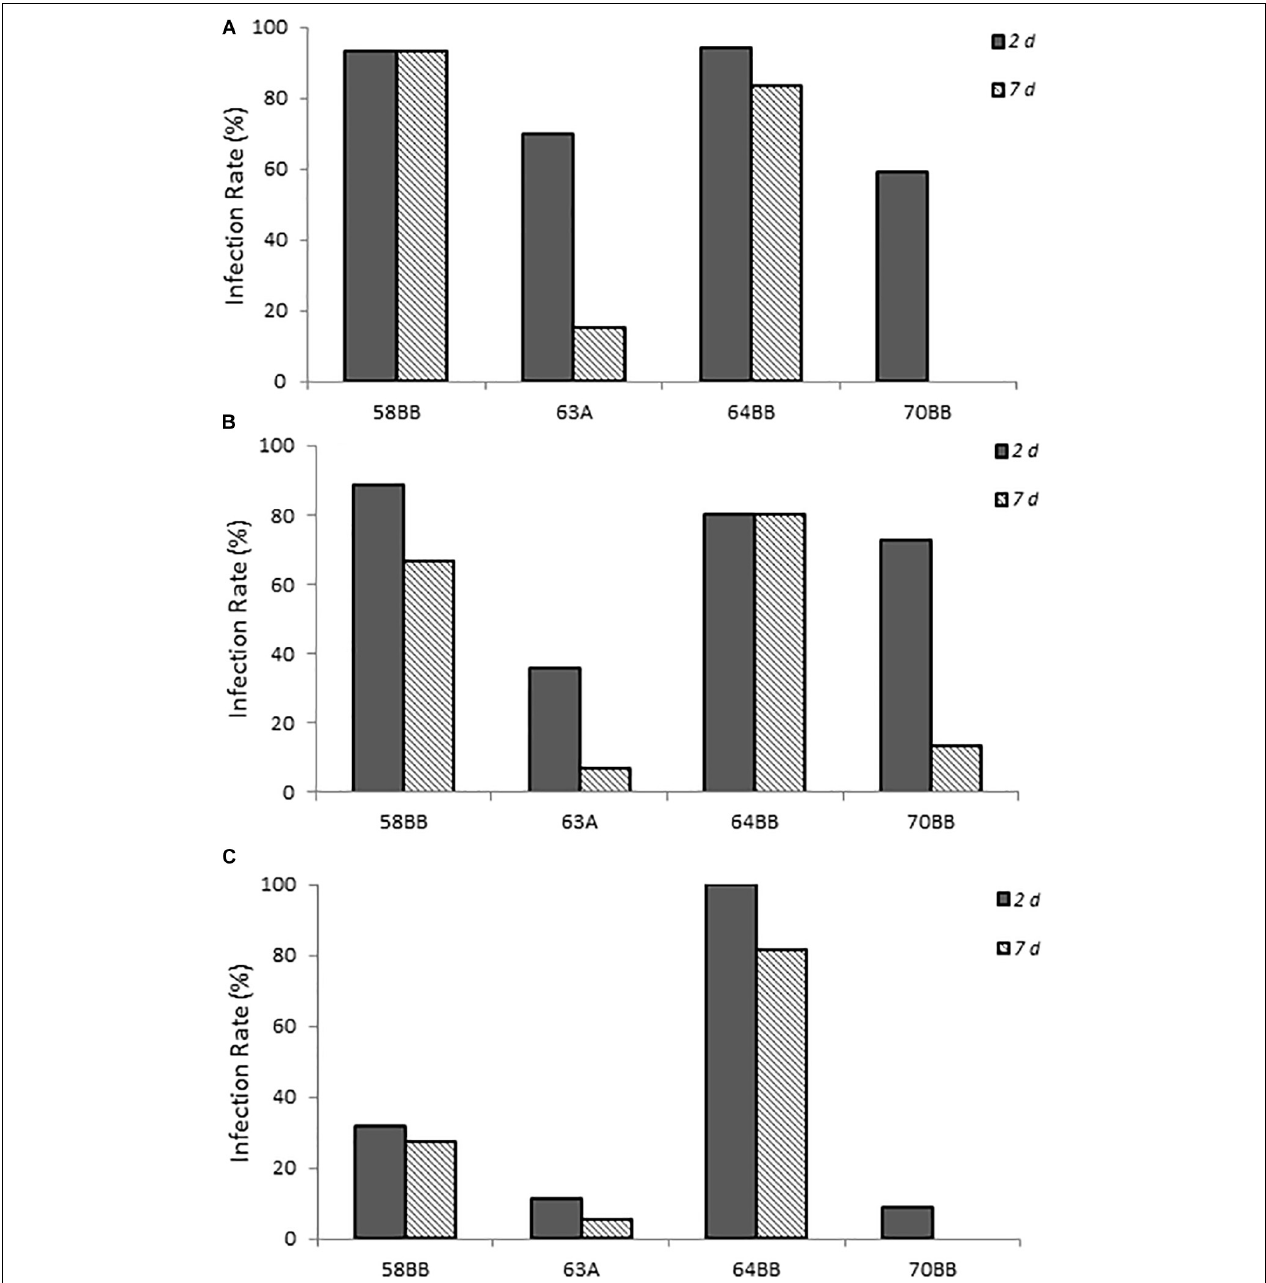
FIGURE 4 | Infection rates of environmental isolates of Campylobacter spp. (A–C) show chicks infected with Campylobacter spp. environmental isolates at doses A–C, respectively, as described in Supplementary Table S1 . Percent infected was determined by dividing the number of infected chicks by the total number of chicks inoculated with the various Campylobacter species. Chicks were considered infected if fecal samples collected at the various times were positive for Campylobacter spp. as determined by using the passive-filter plating as described in section “Materials and